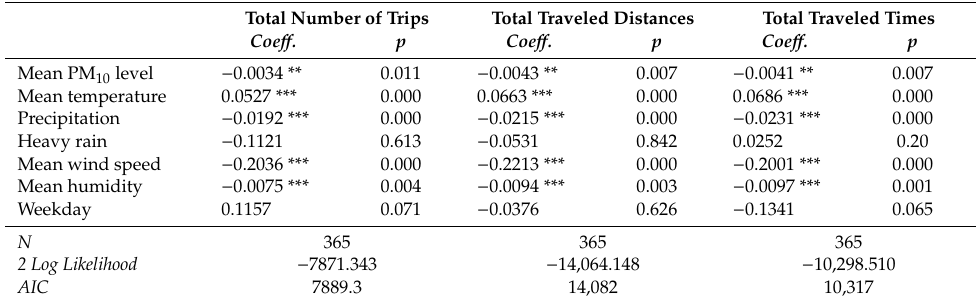
Table 3. Estimation results for bike sharing use using PM 10 level data in all seasons.